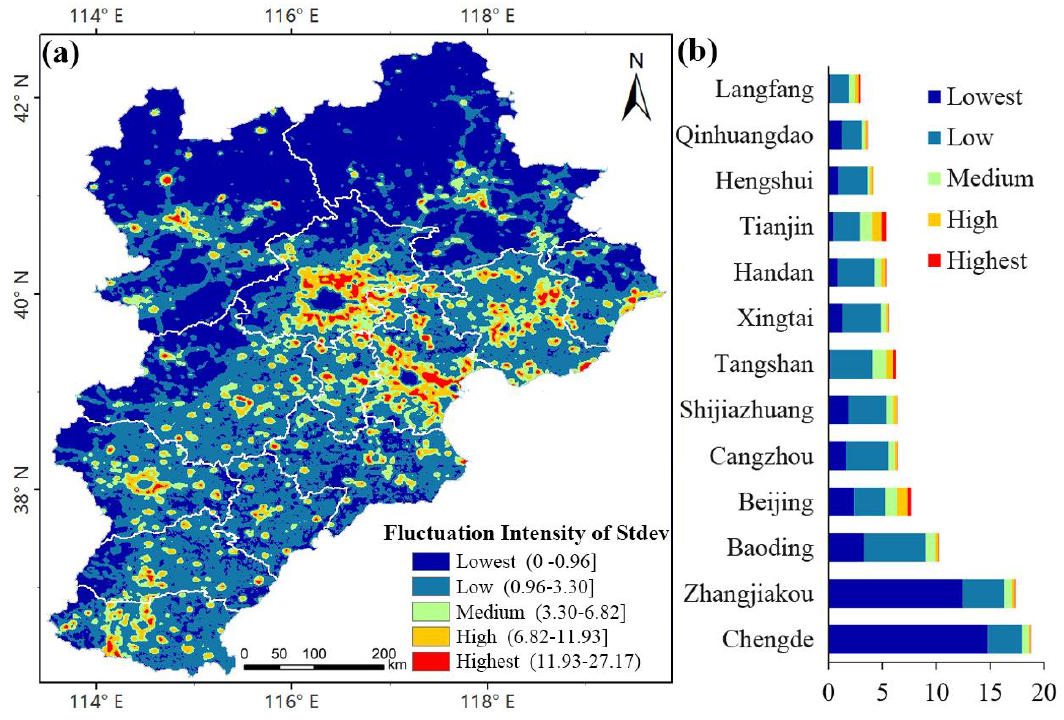
Figure 4. Standard deviation of artificial lighting changes in the Beijing-Tianjin-Hebei region from 1992 to 2012: ( a ) fluctuation characteristics of Stdev; ( b ) proportion of Stdev at prefecture-level cities (%).